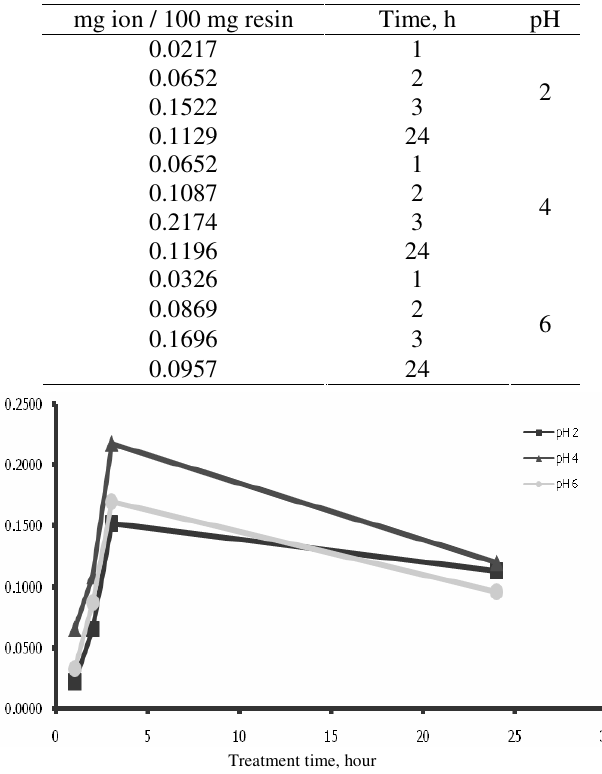
Table 2 . The effect of treatment time on the loading capacity.